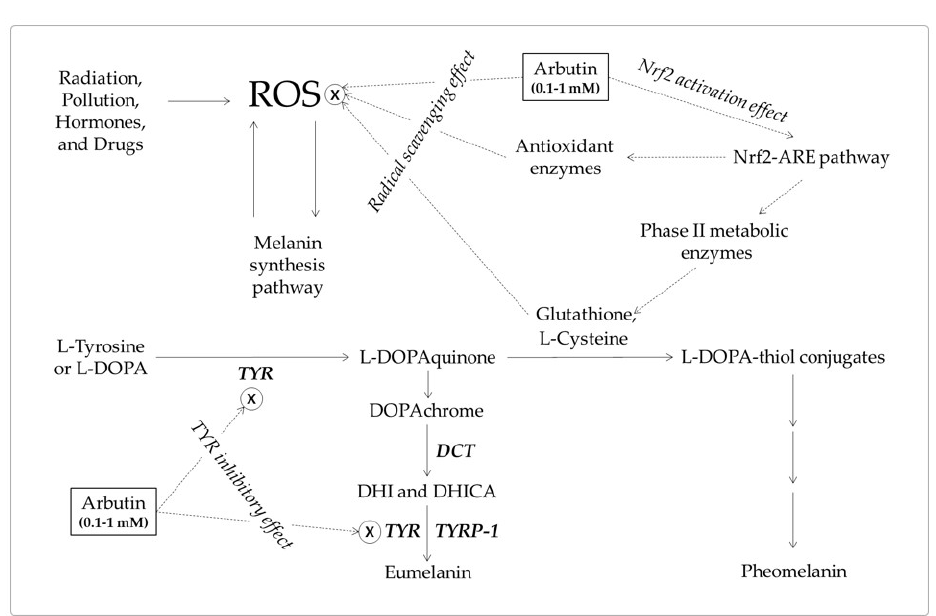
Figure 6. A hypothetical mechanism for the inhibition of eumelanin synthesis by arbutin involving its tyrosinase (TYR) inhibitory and antioxidant activities. Arbutin inhibits the catalytic activity of TYR. It also scavenges reactive oxygen species (ROS) from various sources that can induce melanin synthesis, apoptosis, or tumorigenesis. It can activate the erythroid 2-associated factor 2 (Nrf2)-antioxidant responsive elements (ARE) pathway to enhance the antioxidant capacity of cells. Increased thiol compounds, such as L-cysteine and glutathione, can react with L-DOPAquinon to form DOPA-thiol conjugates, which enter the pheomelanin synthesis pathway. As a result, eumelanin synthesis via DOPAchrome can be selectively downregulated by arbutin. Inhibitory targets of arbutin are indicated with ⊗